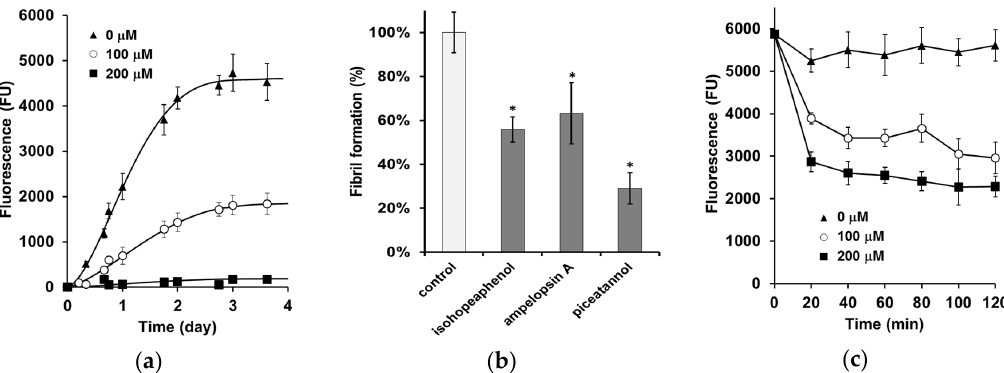
Figure 1. The structure of stilbenes.